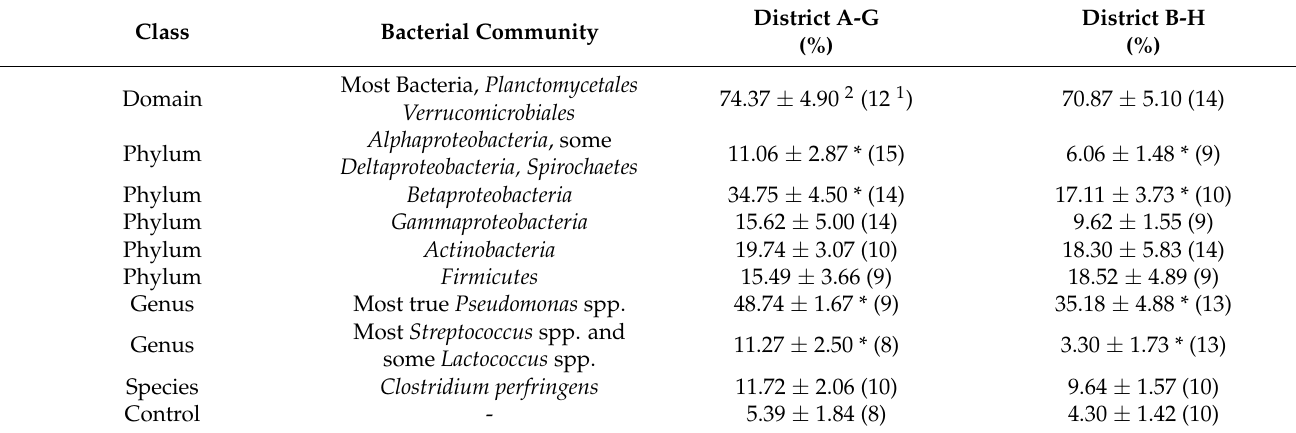
Table 5. Percentage distribution of bacterial communities present in the two TWM hotspots after operations had